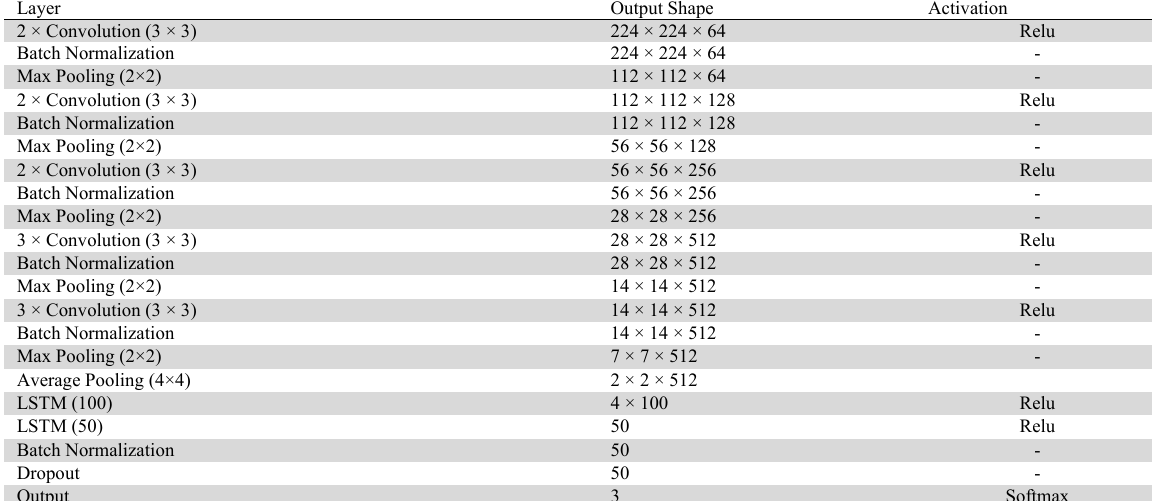
The summary of CNN-LSTM model Layer